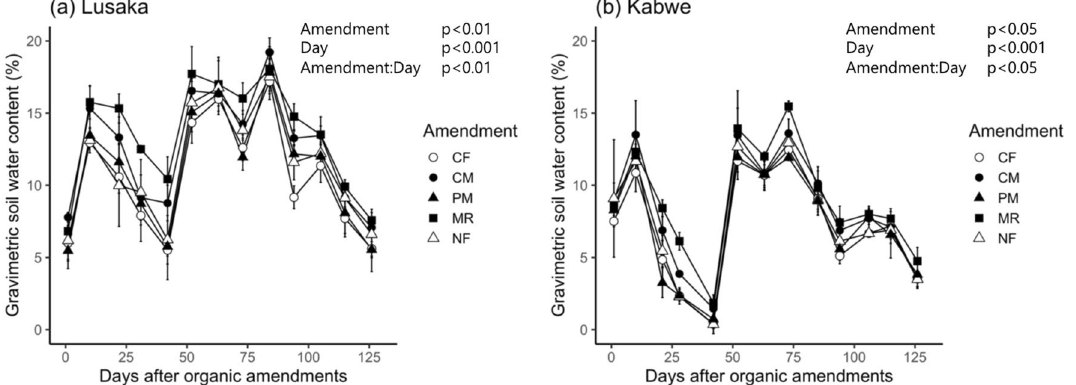
Figure 1. Temporal changes in soil gravimetric moisture content at the ( a ) Lusaka and ( b ) Kabwe sites. Different shapes represent the different fertilizer treatments. The levels of significance at the top of the panels were based on mixed model results for repeated measurements. Error bars represent the standard deviation of the mean ( n = 3). CF: chemical fertilizer amendment, CM: cattle manure amendment, PM: poultry manure amendment, MR: maize residue amendment, and NF: no fertilizer